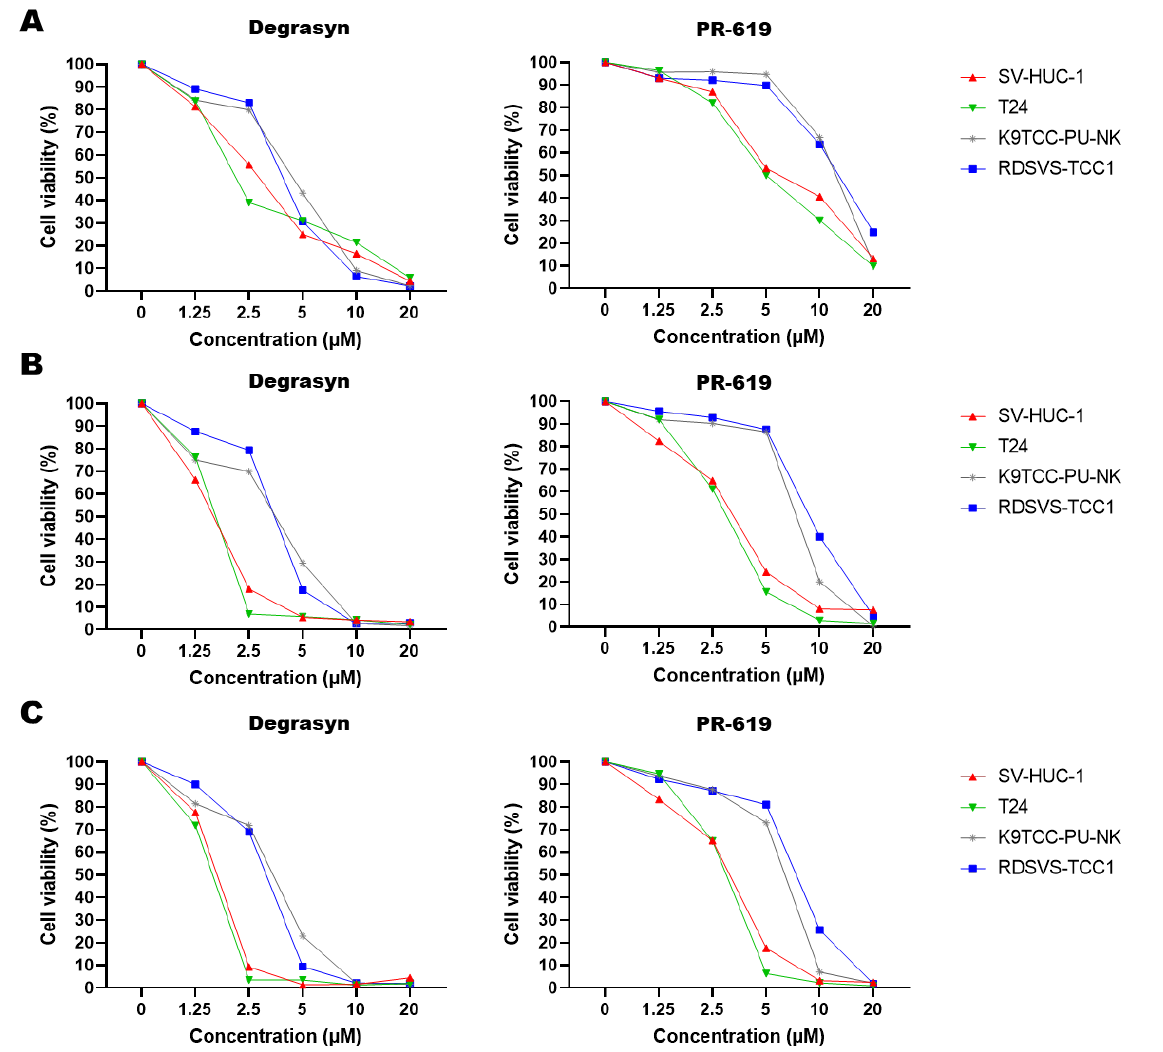
Figure 3. Analysis of Degrasyn and PR-619 influence on the cell proliferation of SV-HUC-1, T24, K9TCC-PU-NK, and RDSVS-TCC1 cell lines (MTT assay) after 24 ( A ), 48 ( B ), and 72 ( C ) hours with increasing concentrations of the drugs (data for 1.25, 2.5, 5, 10, and 20 µ M). Values are presented as means ± standard deviations (SD) of three independent experiments.